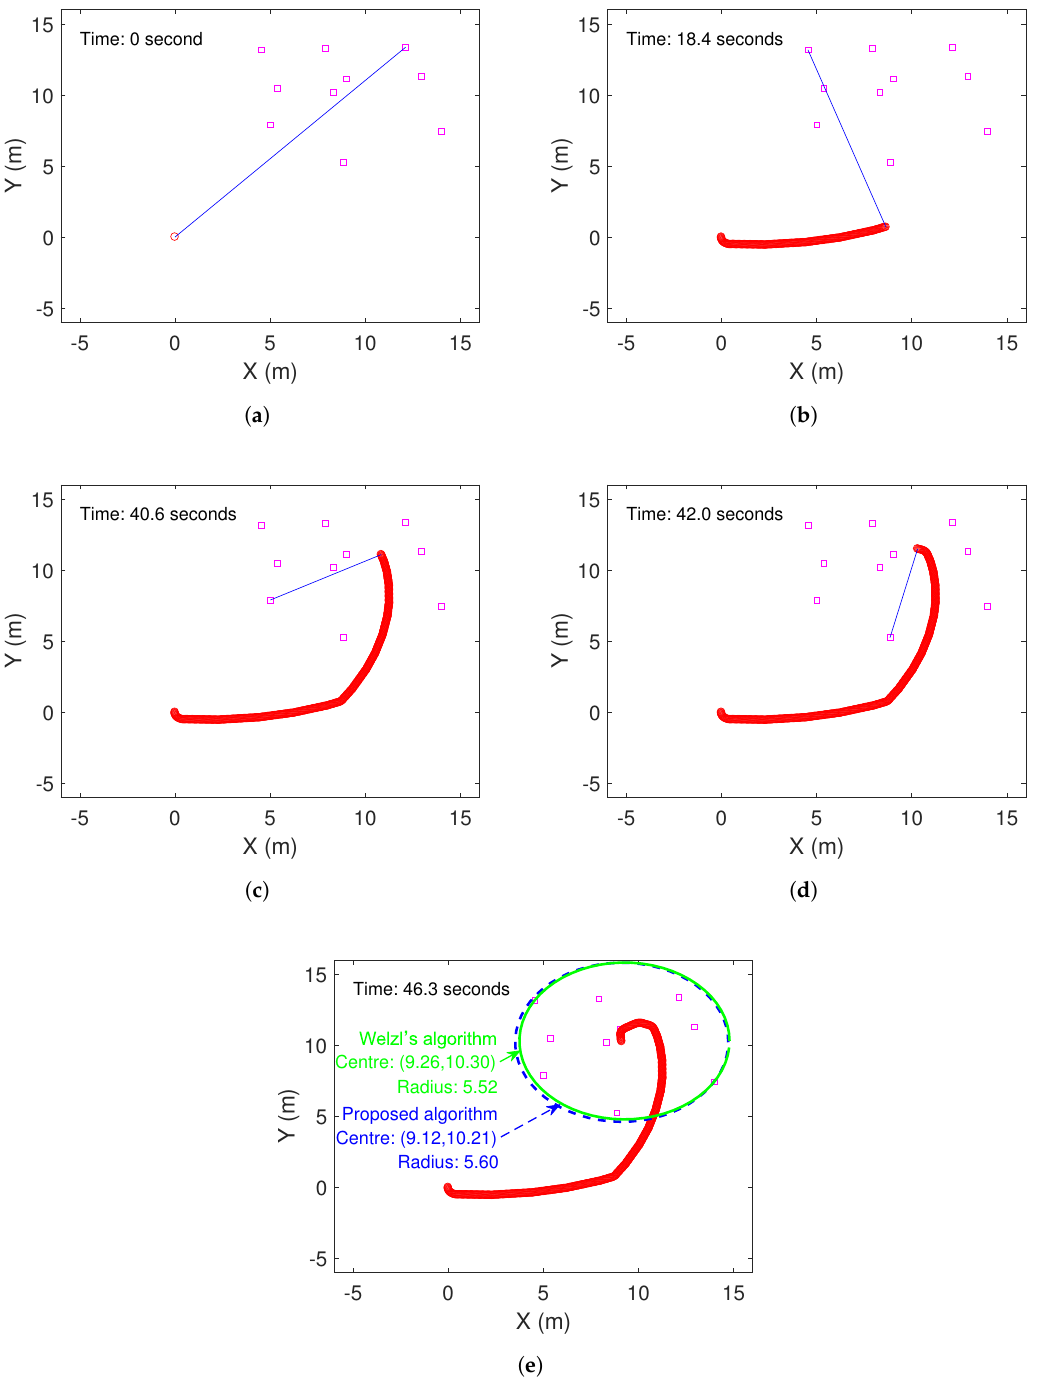
Figure 5. The simulation result with 10 static targets. ( a – d ) show several key points on the path where the robot selects different targets. ( e ) compares with Welzl’s algorithm in terms of the smallest circle center and radius. A video for this example is available at: https://youtu.be/FVEzQohNgcw (accessed on 11 September